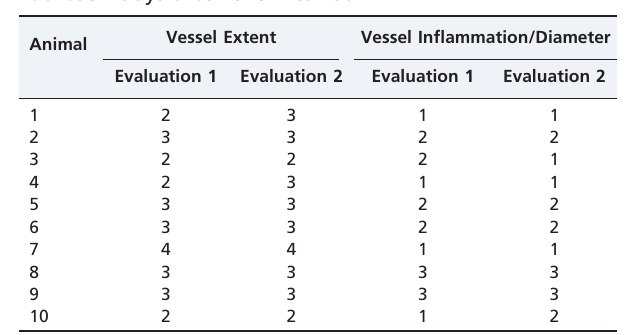
Table 1 - Blinded photographic analysis of vessel extent and inflammation/diameter in the control group, fourteen days after chemical burn.